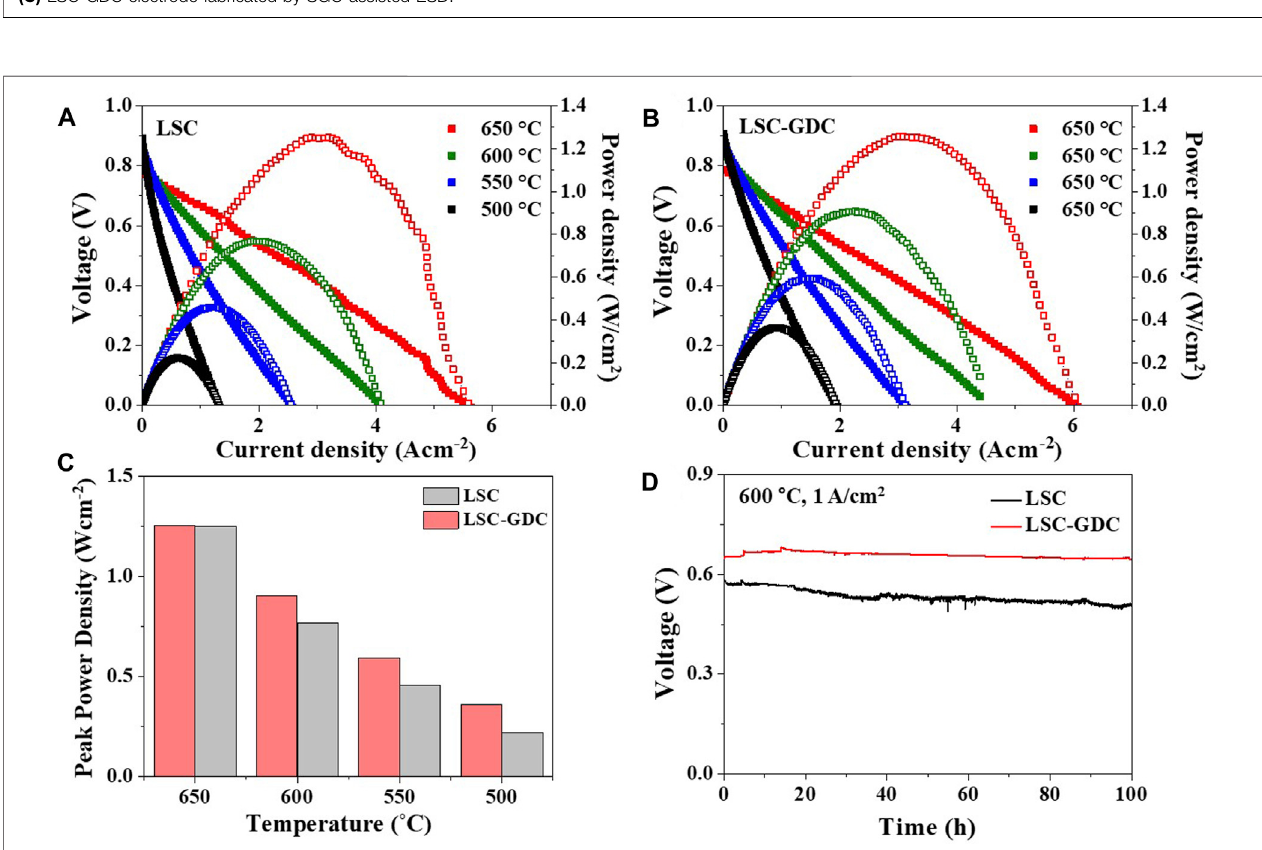
Frontiers in Chemistry |